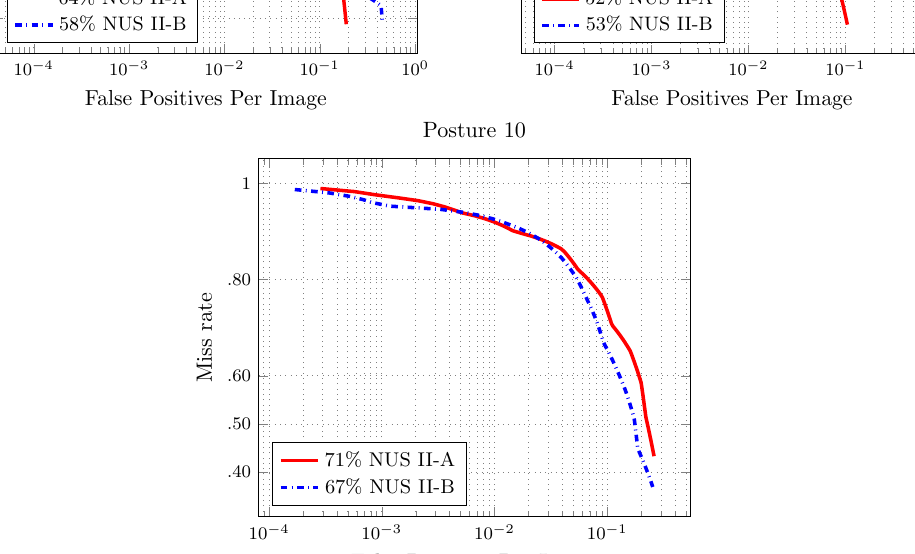
Figure 8. Results of the full image evaluation for Hand Postures 6–10 in Figure 2. The score is the log average of the miss